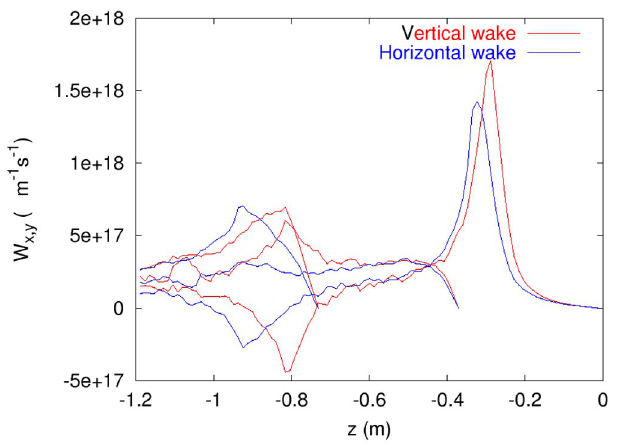
FIG. 71. (Color) Horizontal and vertical dipole wake functions for a uniform SPS bunch obtained by displacing three several bunch slices in a field-free region and computing the resulting force on axis